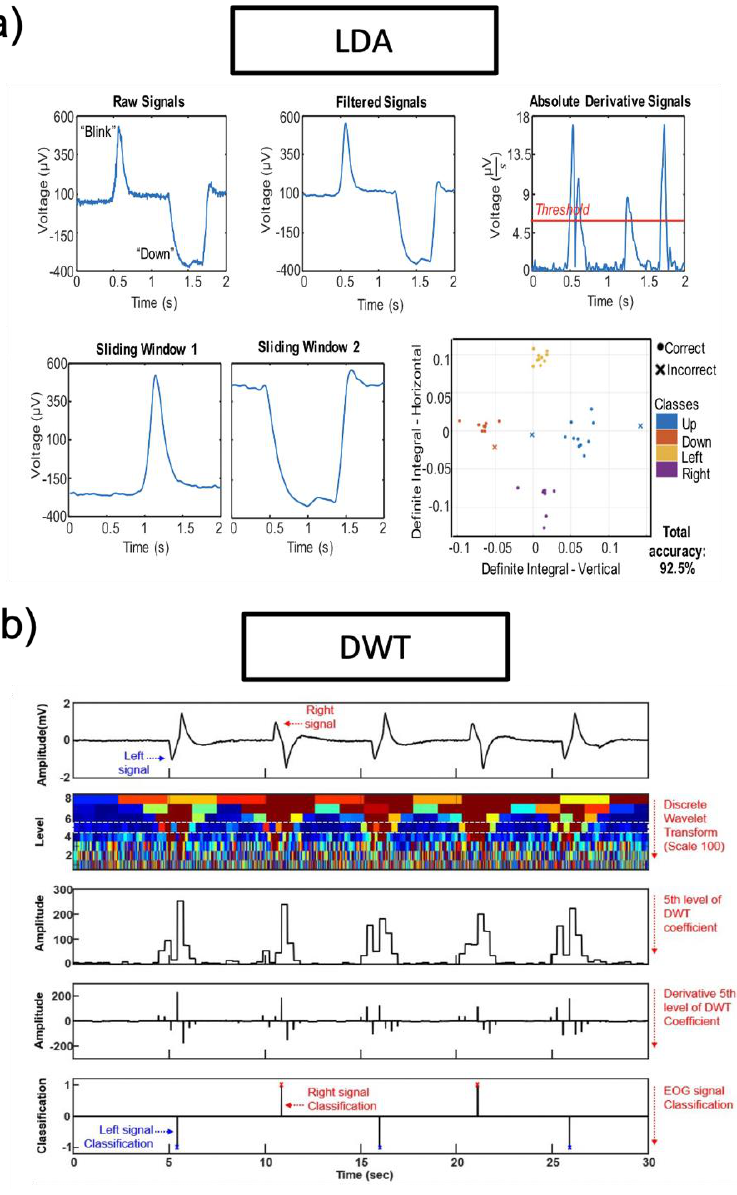
Figure 9. Machine learning for data analysis ( a ) Signal processing sequence with an LDA